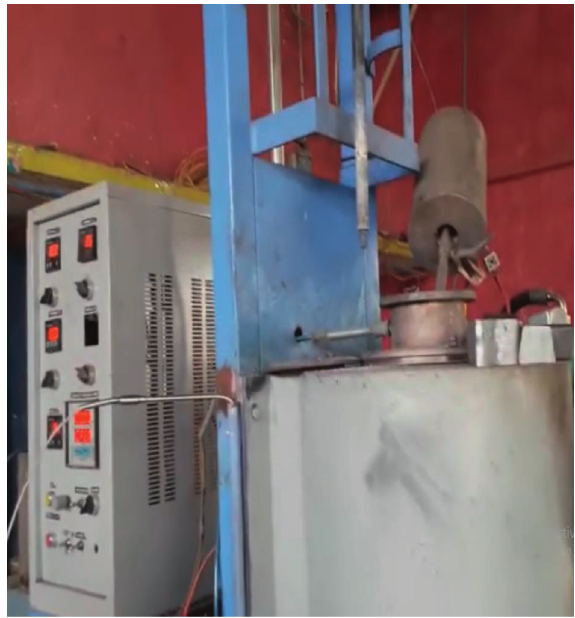
Figure 1: Stir casting machine. Table 1: Details of experimental parameters (L9). Trail of experiment no.